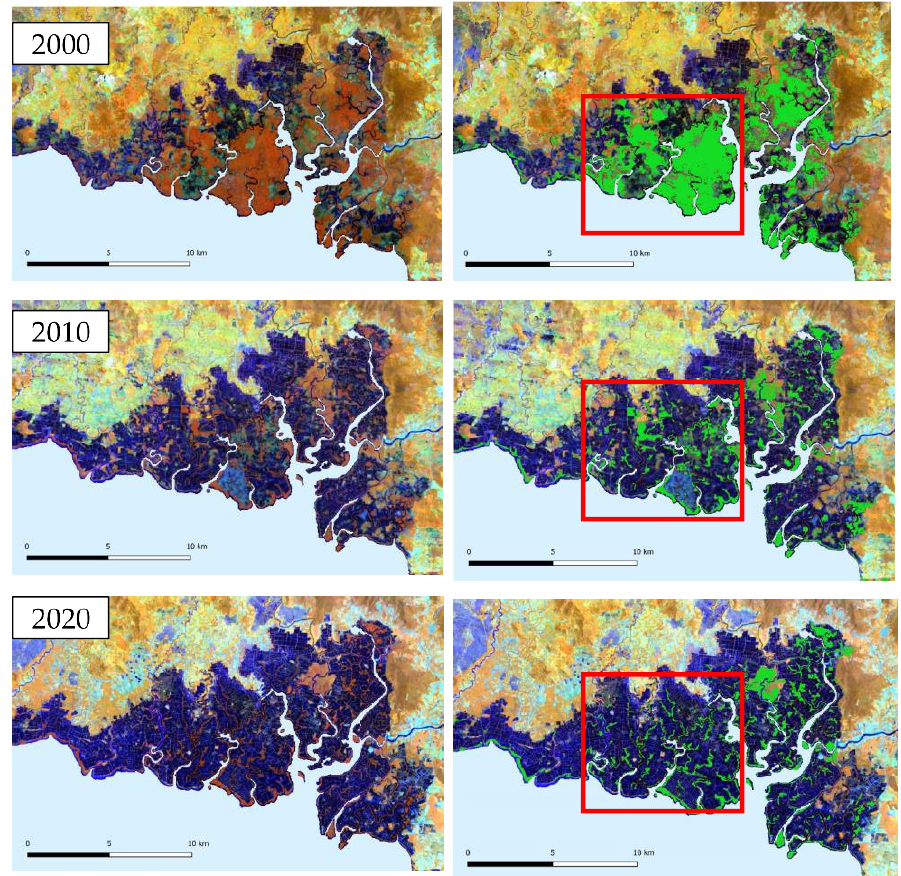
Figure 5. Visualization results in year 2000, 2010 and 2020. The left column is Landsat composite images (NIR, SWIR 1, Red) and the right column is Landsat image with the classified mangrove area (green color).